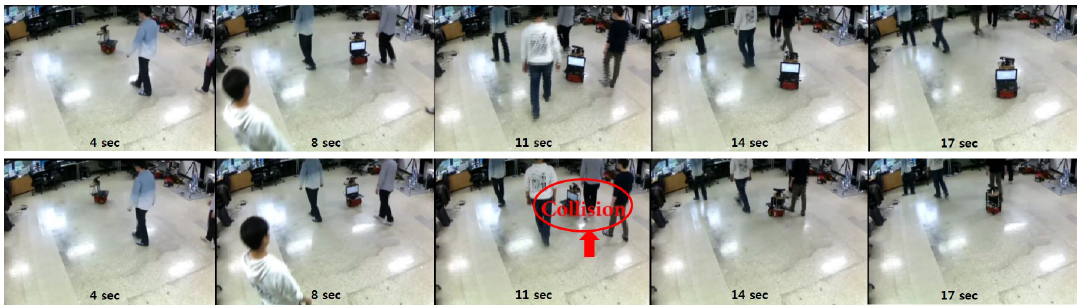
Figure 10. Snapshots from a motion control experiment in a laboratory with four moving pedestrians using: FactGP C ( top ); and GP-MC ( bottom )